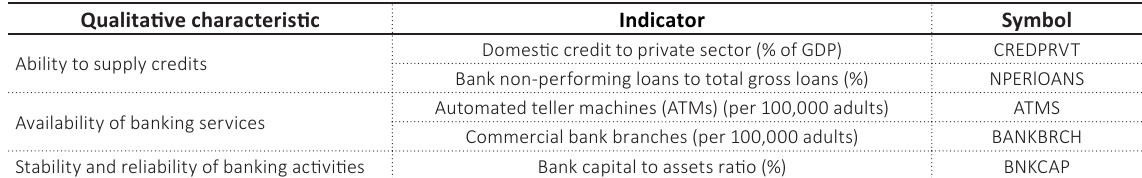
Table 1. List of independent variables